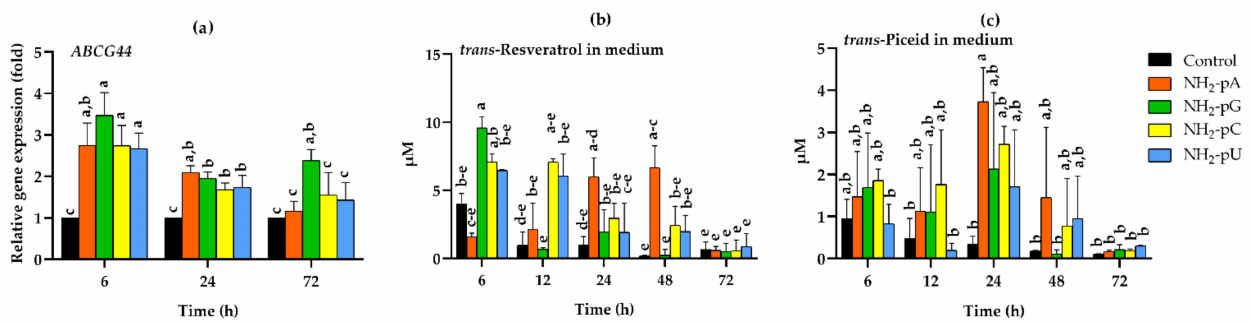
Figure 5. Expression of the VvABCG44 resveratrol transporter gene in the cells of Vitis vinifera cv. Monastrell treated with 5 µ M nucleoside 5 (cid:48) -phosphoramidates, and accumulation of stilbenes in the spent medium. ( a ) VvABCG44 , resveratrol transporter gene; ( b ) accumulation of trans -resveratrol; ( c ) accumulation of trans -piceid. Total RNA was reverse-transcribed into cDNA and used as a template for real-time quantification PCR reaction as described in the Section 4. Specific primers were designed for VvABCG44 and EF α 1 (elongation factor 1-alpha, which was used as an endogenous control). The expression level of VvABCG44 in the control cells (no nucleotide added) was set to 1. Accumulation of trans -resveratrol and trans -piceid was determined using the HPLC method as described in the Section 4. Values are the mean ± standard deviation of the three replicates. Values without a common letter were significantly different according to ANOVA and Tukey’s HSD multiple range test ( p ≤